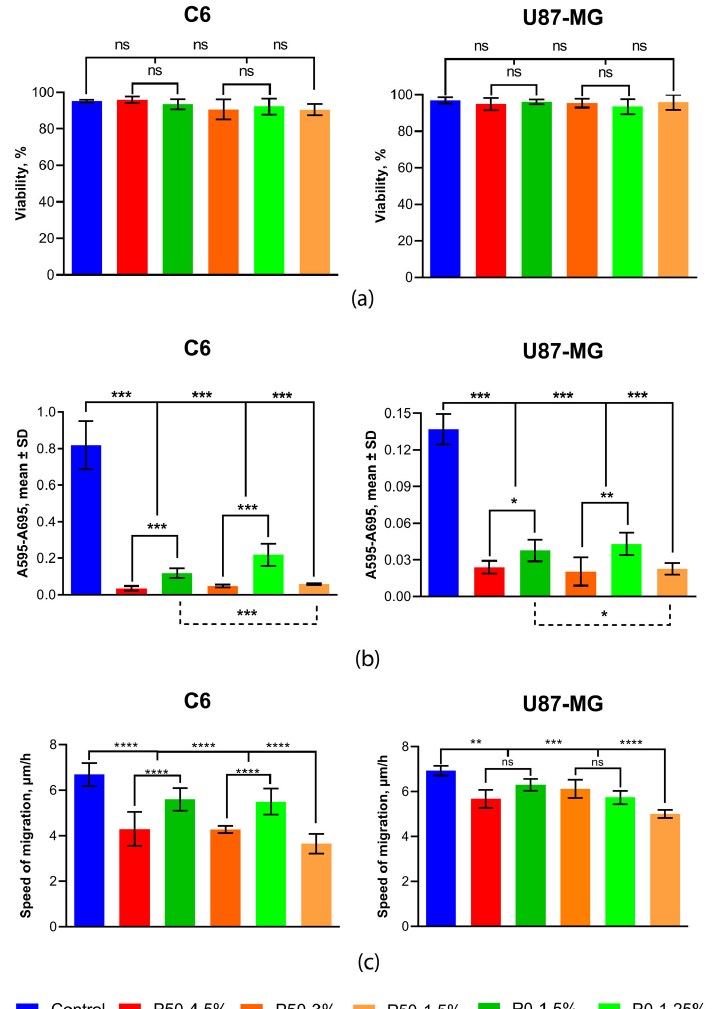
Figure 7. The effect of pectin hydrogels on tumor cells: ( a ) cell viability, ( b ) metabolic activity, ( c ) migration activity, * p < 0.05, ** p < 0.01, *** p < 0.001 **** p < 0.0001.